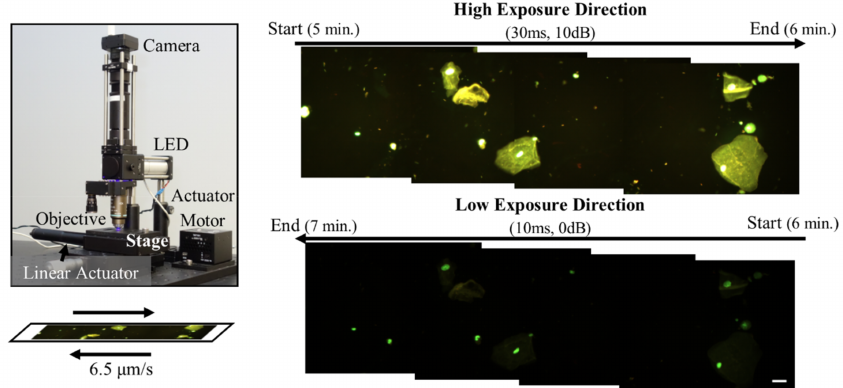
Figure 1. The point-of-care (POC) system (left) consisted of a Point Gray color camera, 488 nm LED, 40x Nikon objective, stage, linear actuator, and actuator motor. The diagram below the system image demonstrates the slide translation, which travels at 6.5 µ m / s in two directions. The camera field-of-view was not perfectly parallel to the direction of translation, therefore the image mosaics (right) were tilted. The first direction used high exposure camera settings with an exposure of 30 ms and a gain of 10 dB to image low fluorescence intensity objects (bacteria). The second direction used an exposure of 10 ms and a gain of 0 dB to image high fluorescence intensity objects (epithelial cells and leukocytes). Scale bar represents 20 µ m. Images enhanced for